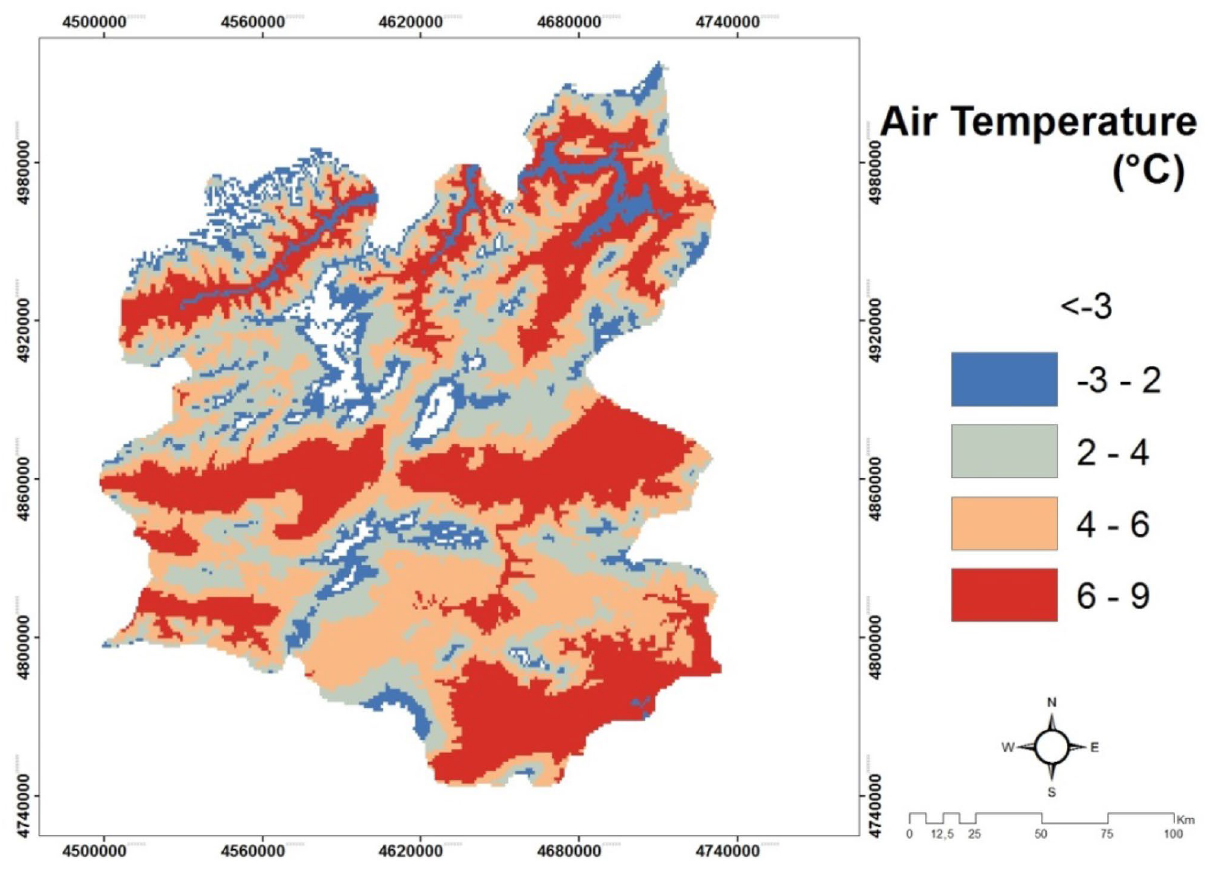
Figure 8. The temperature map of